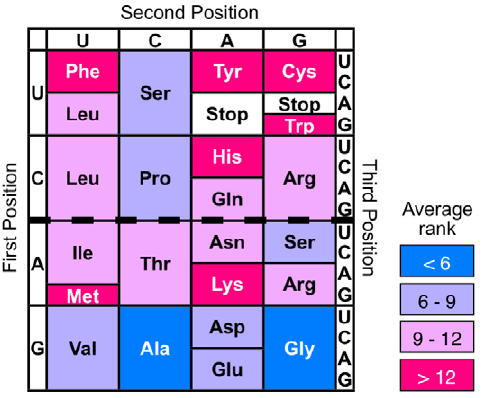
Figure 1. The universal genetic code. The average rank represents the chronological order of amino acid addition to the genetic code. The values calculated from , 60 criteria were Gly, 3.5; Ala, 4.0; Asp, 6.0; Val 6.3; Pro, 7.3; Ser, 7.6; Glu, 8.1; Thr, 9.4; Leu, 9.9; Arg, 11.0; Asn, 11.3; Ile, 11.4; Gln, 11.4; His, 13.0; Lys, 13.3; Cys, 13.8; Phe, 14.2; Tyr, 15.2; Met, 15.4; Trp, 16.5 (data from [3]). The upper half of the table of the genetic code corresponding to codon YNN (Y = T or C; N = T, C, A or G) contains a lot of newly added amino acids ( e.g ., Phe and Cys), while the lower half corresponding to codon RNN (R = A or G) contains the most primitive amino acids, Ala and Gly.